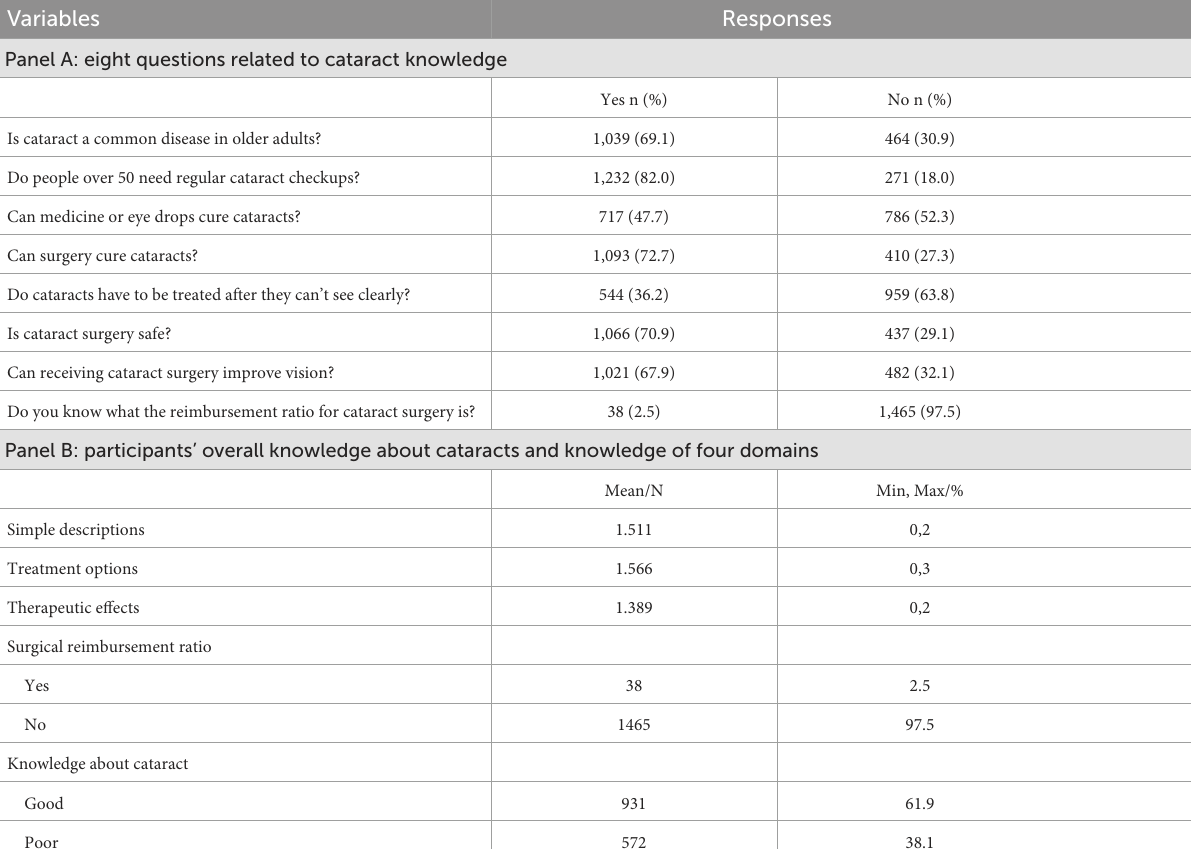
TABLE 2 Participants’ knowledge about cataracts of adults aged 50 and above in rural western China